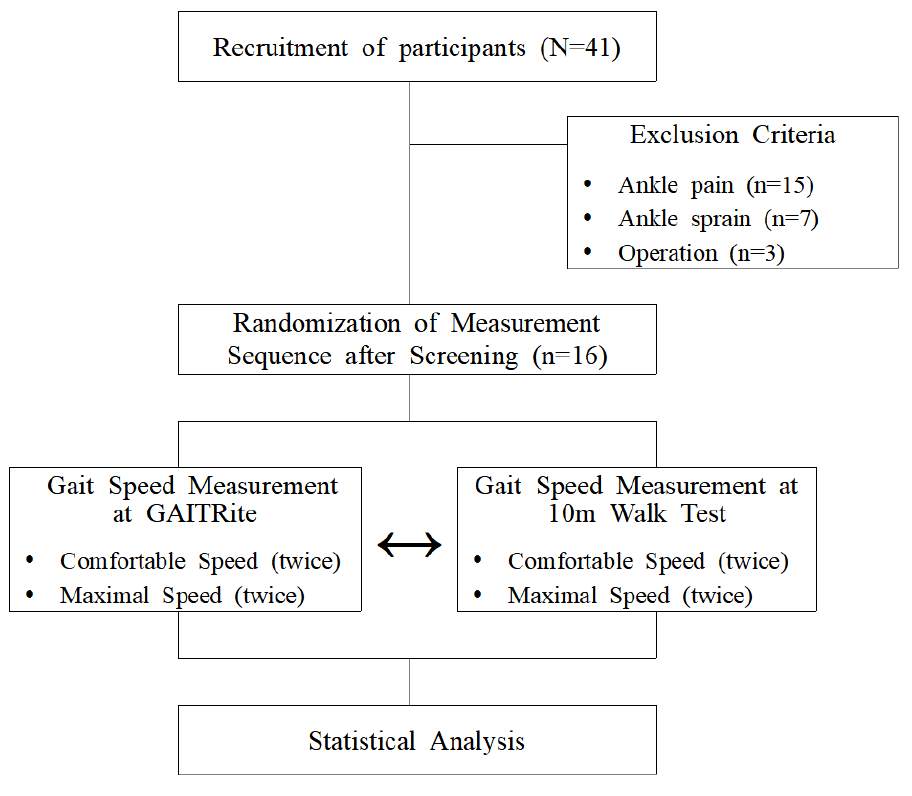
Figure 1. Flow chart.